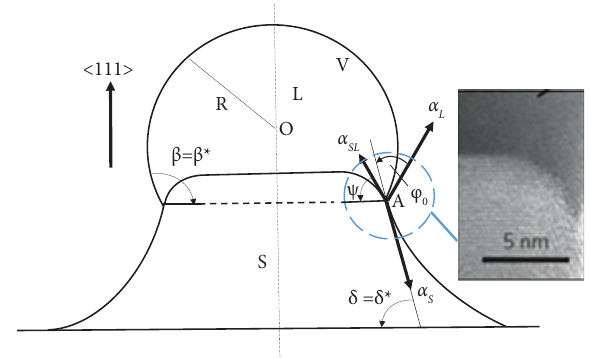
Figure 10: Scheme of NW growth at nonsingular end surface. SEM image of the Si NW crystallization front section curved near the